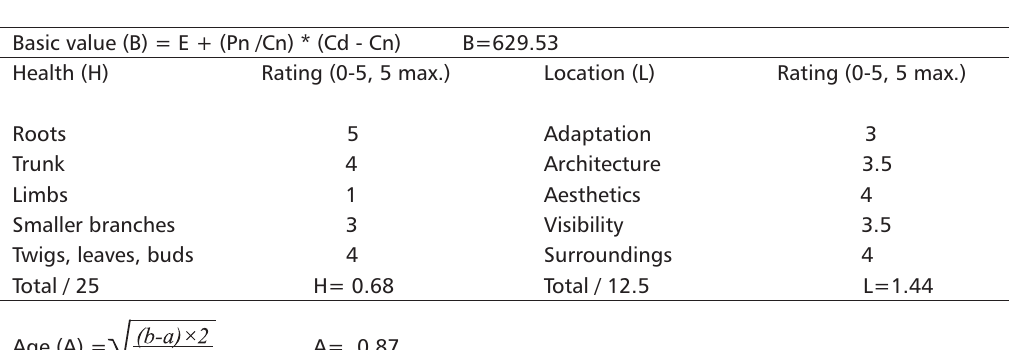
Locality: Zagreb, Ribnjak